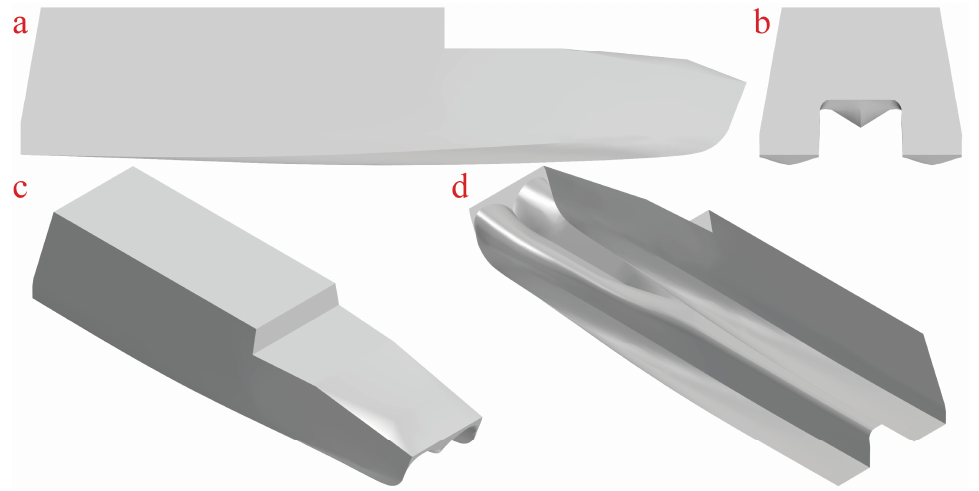
Figure 1. USV model ( a ) side view; ( b ) stern view; ( c ) side view from the bow; ( d ) side view from the stern).